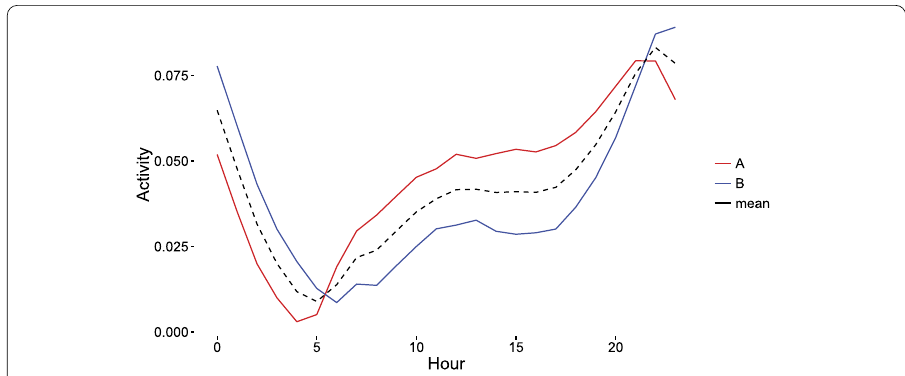
Figure 4 Activity patterns corresponding to the two population groups. The red line, A corresponds to the daily activity pattern of a population with regular working hours. The blue line, B corresponds to the other group who stay up until later in the evening and wake up later as well. The dashed line marks the average activity of all